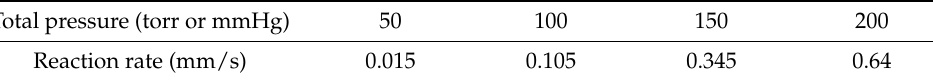
Table 3. Reaction rate with a cross-sectional diameter 23